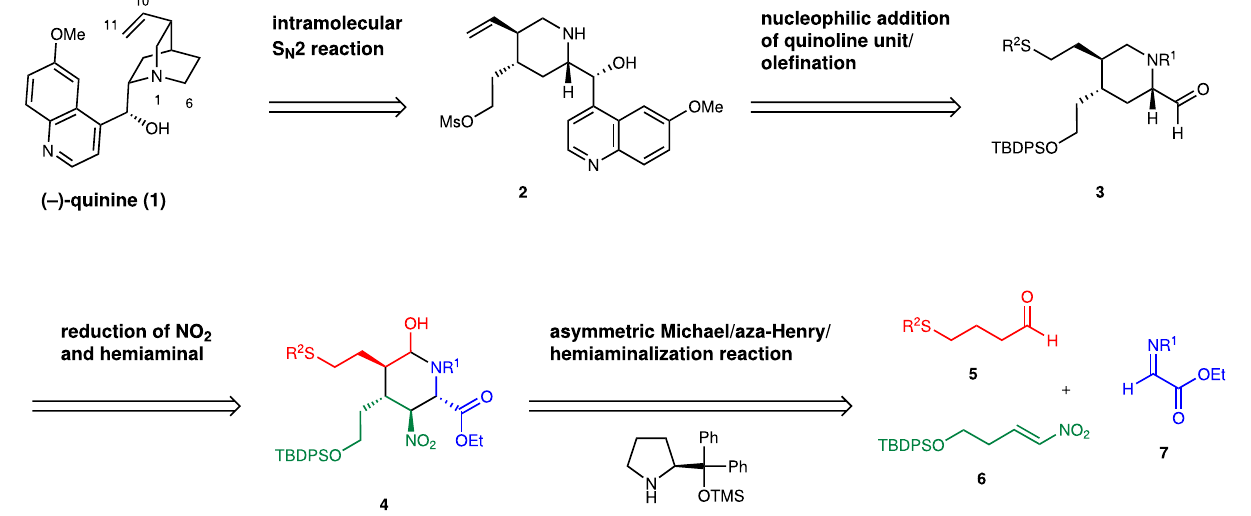
Fig. 1 | Retrosynthetic analysis of ( – )-quinine. Organocatalyst-mediated pot-economical synthesis of ( – )-quinine ( 1 ). TBDPS t -butyldiphenylsilyl.